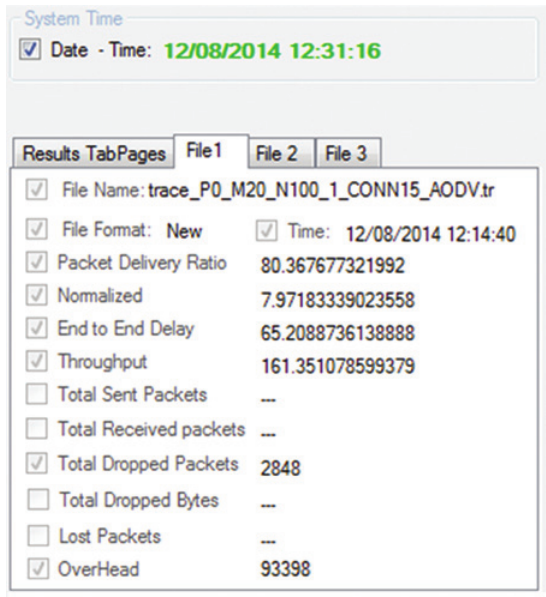
Figure 6. Results Report Tab Pages.